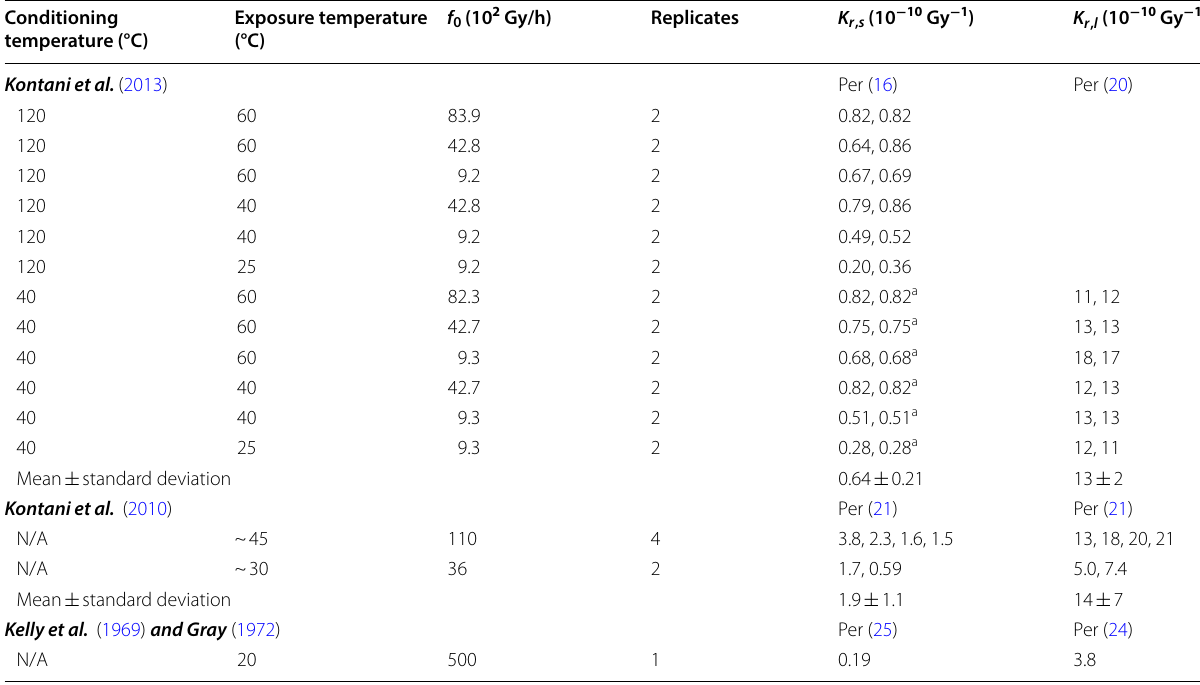
Table 2 Experimental matrices with associated values of K r , s and K r , l